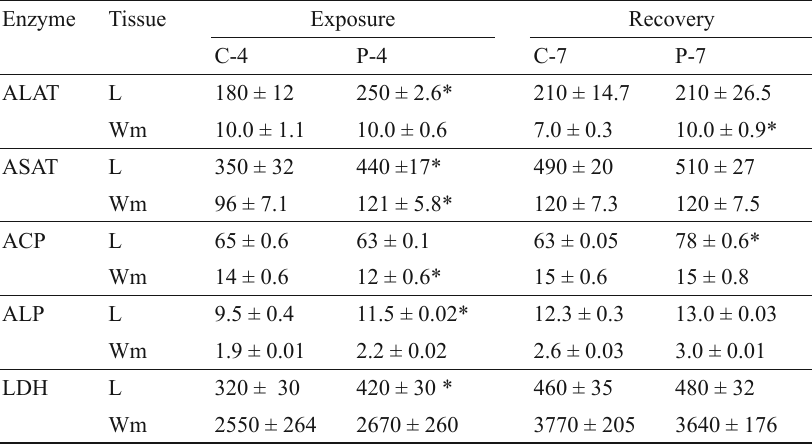
The specific activities of: ALAT (alanine aminotransferase), ASAT (aspartate aminotransferase), ACP (acid phosphatase), ALP (alkaline phosphatase) and LDH (lactate dehydrogenase) are expressed in mIU (mg of protein) -1 . L = liver; Wm = white muscle. C-4 control of exposure for 4 days; P-4 exposed for 4 days; C-7 control of recovery; P-7 recovered for 7days. The values are followed by mean ± SE; (*) difference between the exposed group and the corresponding control is signi fi cant at P <0.05 ( n